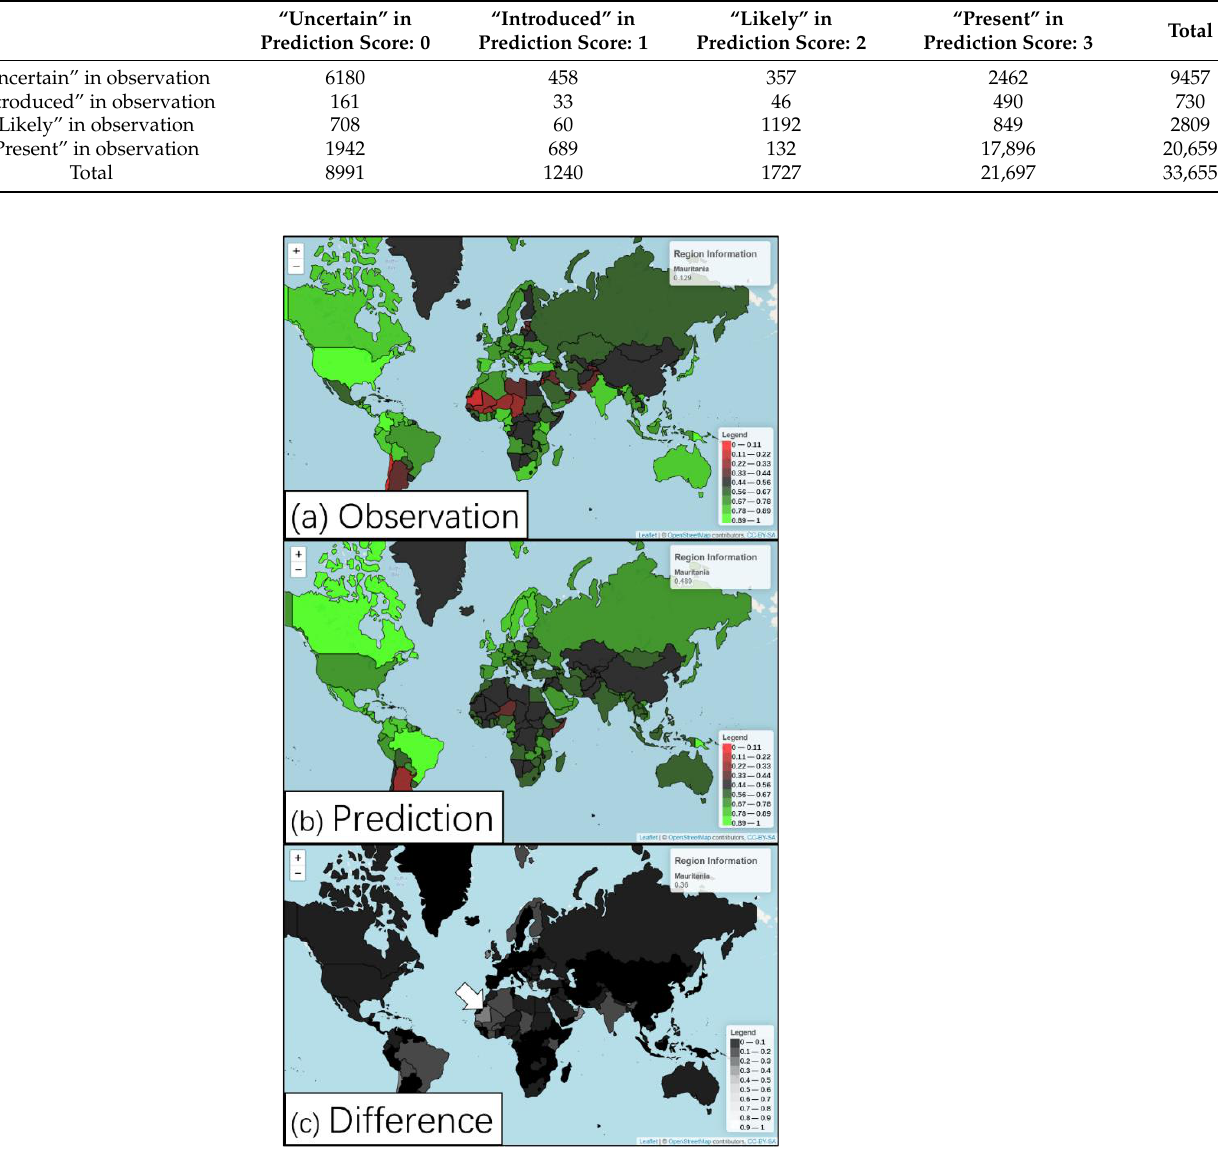
Figure 5. ( a ) Distribution index via observation; ( b ) distribution index via ML prediction; red colour represents areas with a lower distribution of species richness, while green colour represents areas with a higher distribution of species richness; ( c ) the absolute value of the difference between observation and prediction; dark colour indicates a small difference, while light colour suggests a large difference. The white arrow points to West Africa, an area with a large difference. The data are provided in Supplementary Materials Table